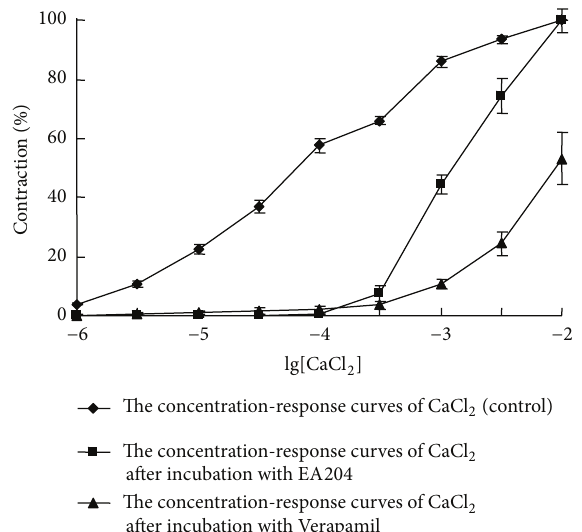
Figure 4: Inhibitory activities of EA204 (10 𝜇 M) and verapamil (0.1 𝜇 M) on the concentration-response curves of CaCl 2 (10 −6 to 10 −2 M) on denuded aortic rings of rabbits. Endothelium was removed mechanically by rubbing with a steel wire. Responses are expressed as a percentage of the maximum contraction induced by CaCl 2 (10 −2 M). Values indicated the means ± SEM ( 𝑛 = 8 ). K + channels to increase extracellular Ca 2+ influx. It was nificantly decreased after the incubation of glibenclamide (as shown in Figures 5 and 6). The results indicate